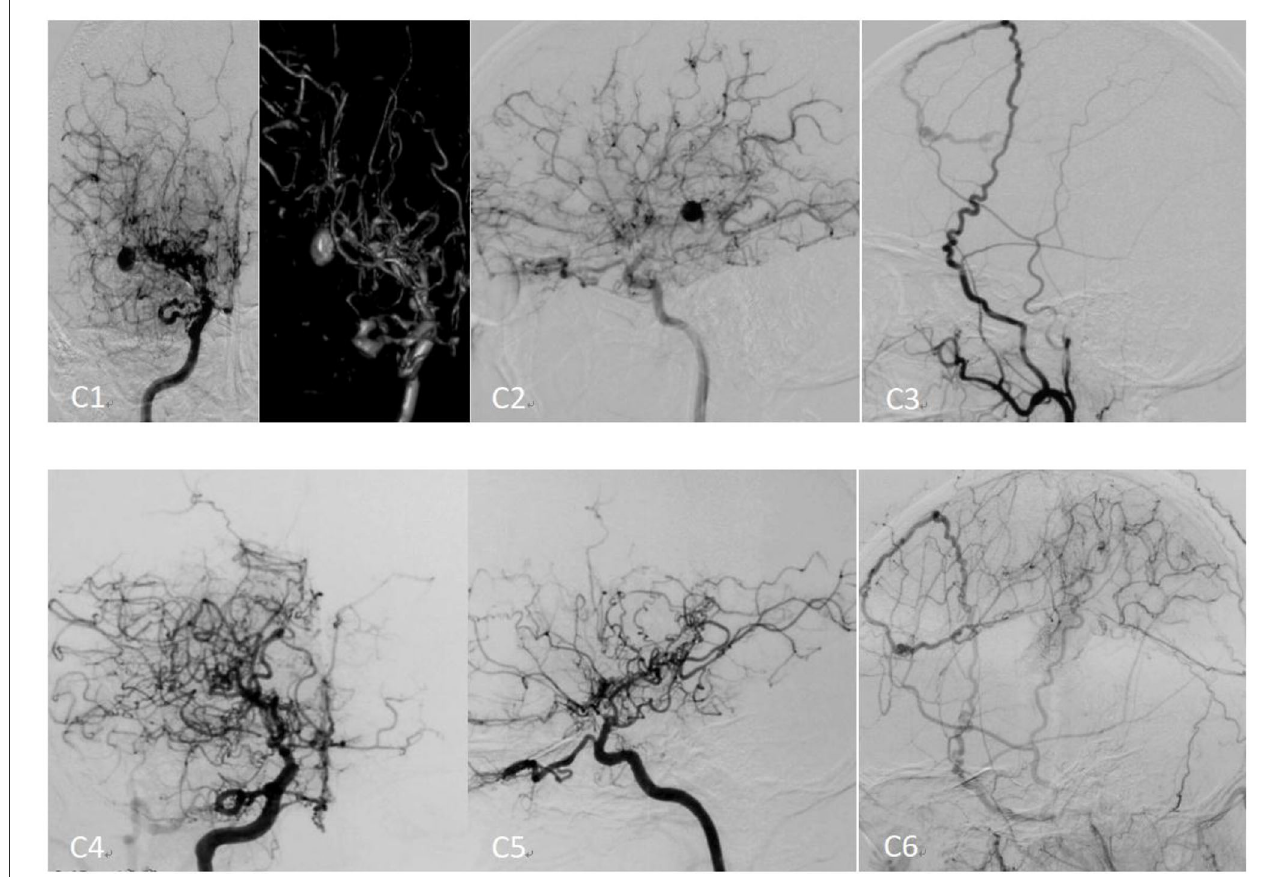
FIGURE3 Preoperative and postoperative cerebral angiography of moyamoya disease[[Inline Image]] treated with encephaloduroarteriosynangiosis (EDAS). (C1) The preoperative right internal carotid angiography (positive) image. (C2) The preoperative right internal carotid angiography (lateral) image. (C3) The preoperative right external carotid angiography (lateral) image. (C4) The right postoperative internal carotid angiography (positive) image. (C5) The postoperative right internal carotid angiography (lateral) image. (C6) The postoperative right external carotid angiography (lateral)